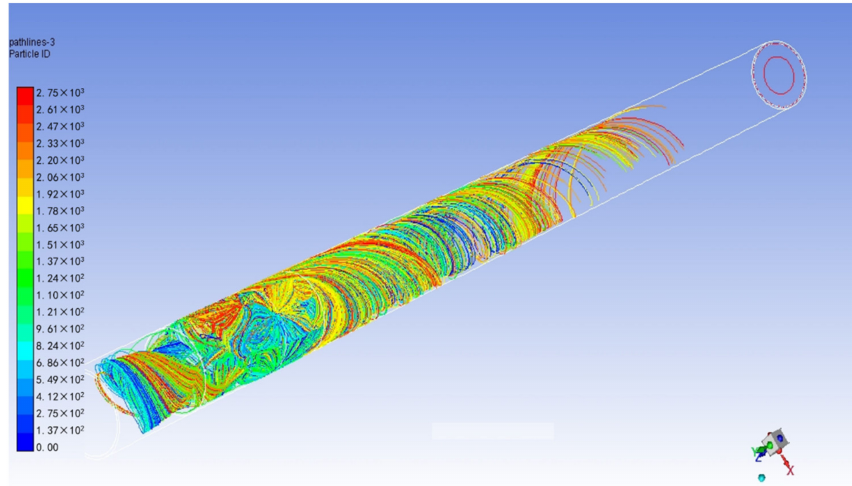
Figure 14. Schematic diagram of rotary jet’s flow